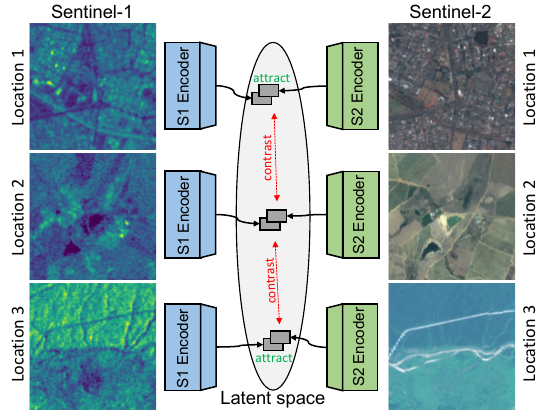
Figure 1. Contrastive SSL with multi-modal remote sensing data. Convolutional encoders are trained to maximize the similarity of latent representations between Sentinel-1/2 images of the same location (positive pairs) while distinguishing them from other scenes (negative